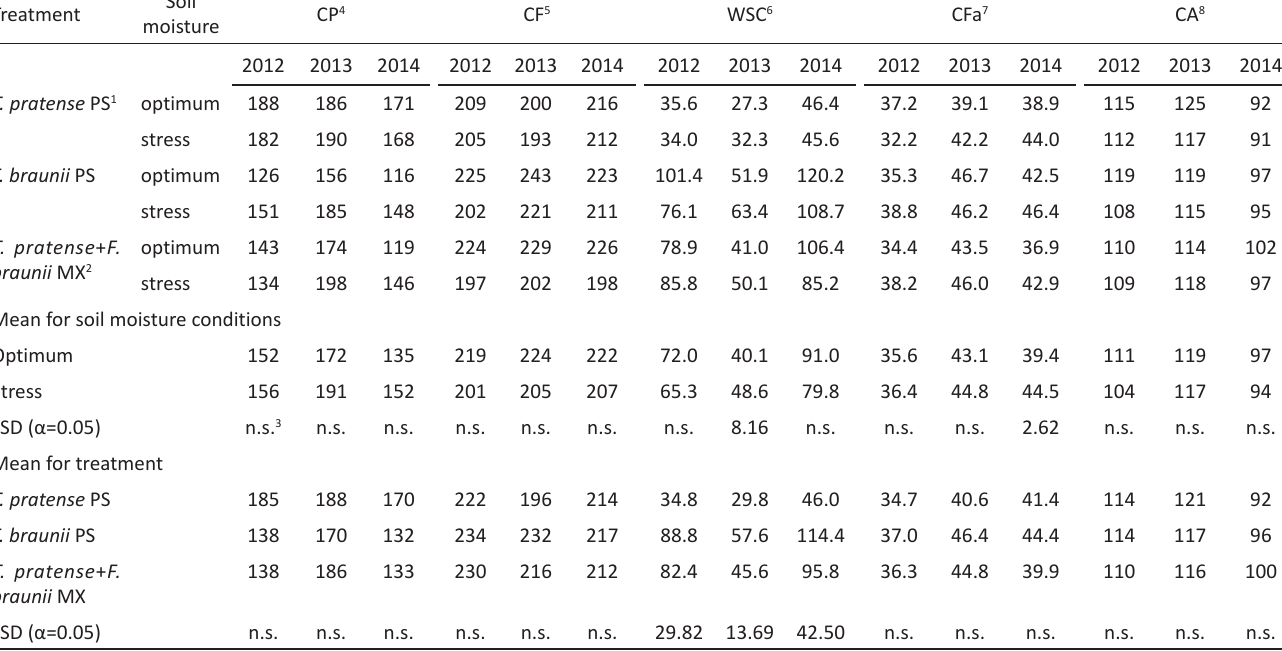
Table 2. Nutritional content of Trifolium pratense and Festulolium braunii grown in pure stand (PS) and in mixture (MX) under optimal and drought stress conditions (g kg -1